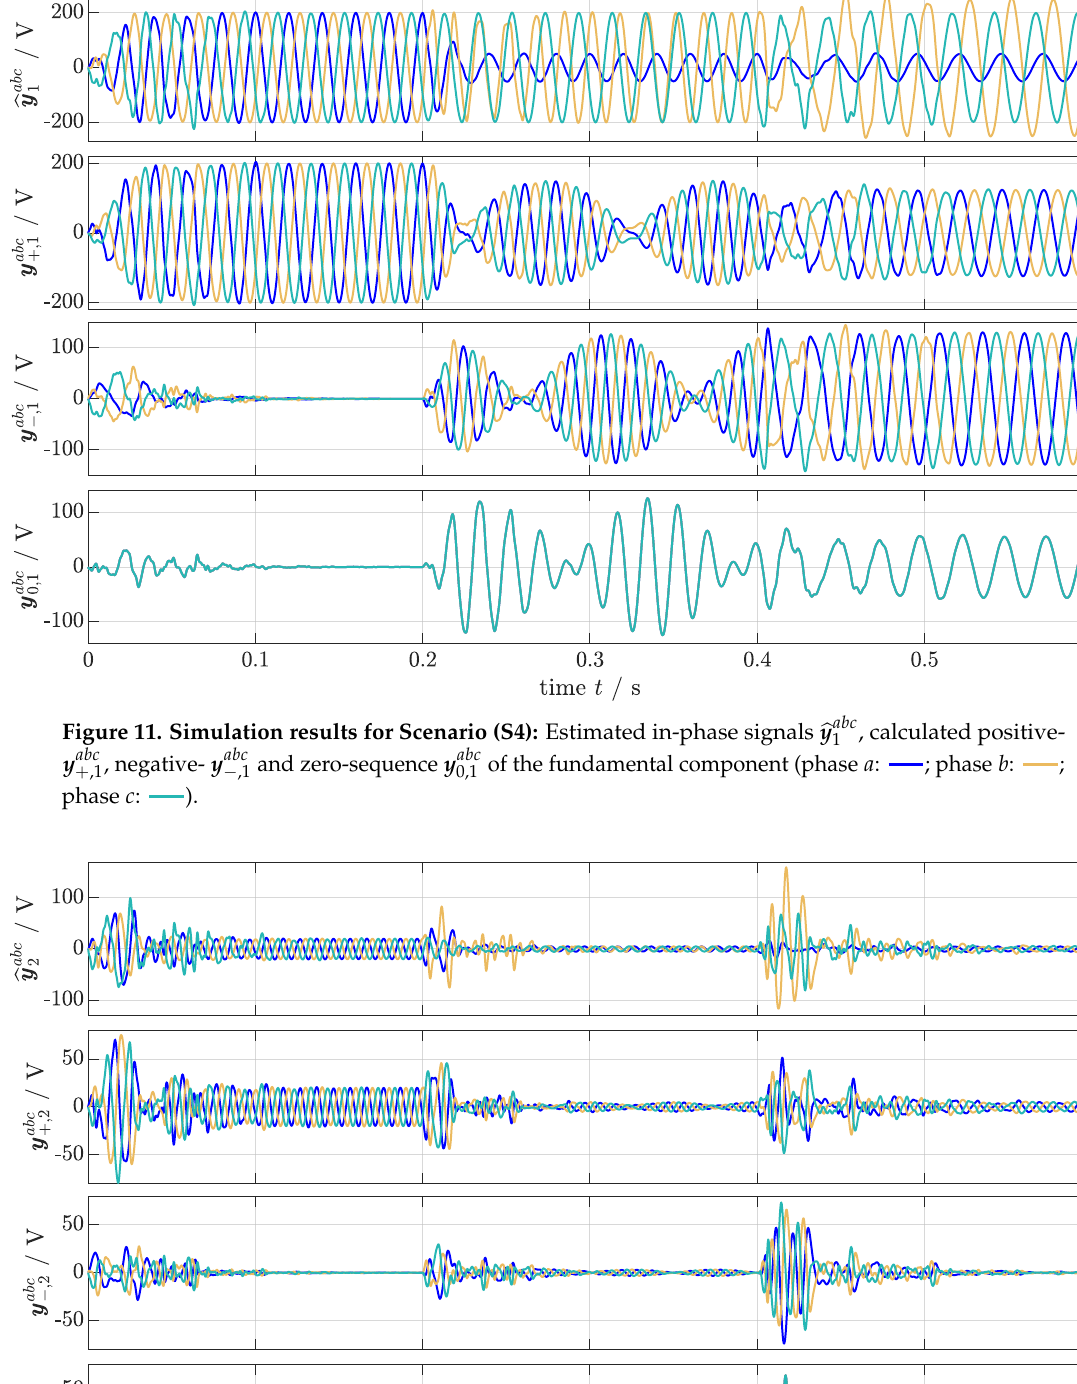
2 , calculated positive- a